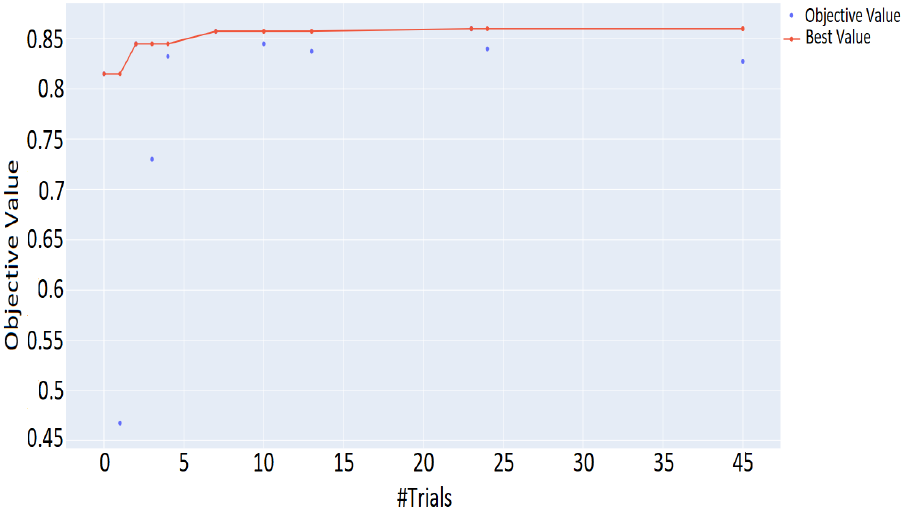
Figure 12. Optimization history of the DNN